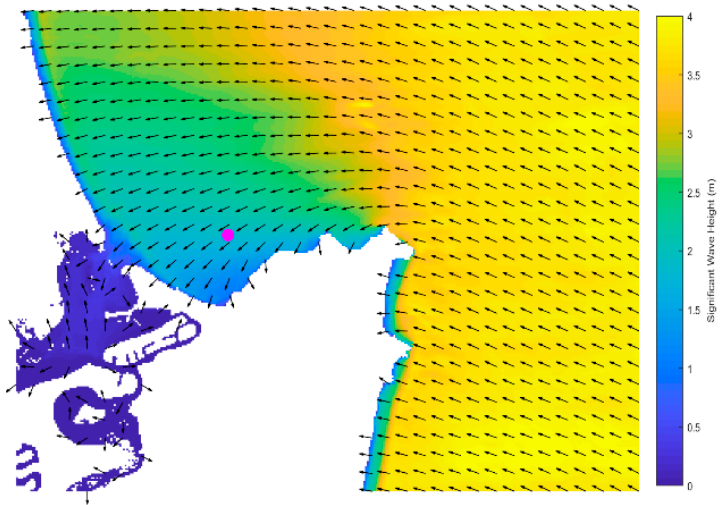
Figure 4. SWAN wave model output from 10:00 22 February 2019 (the ADCP in Laguna Bay is shown by the pink dot).